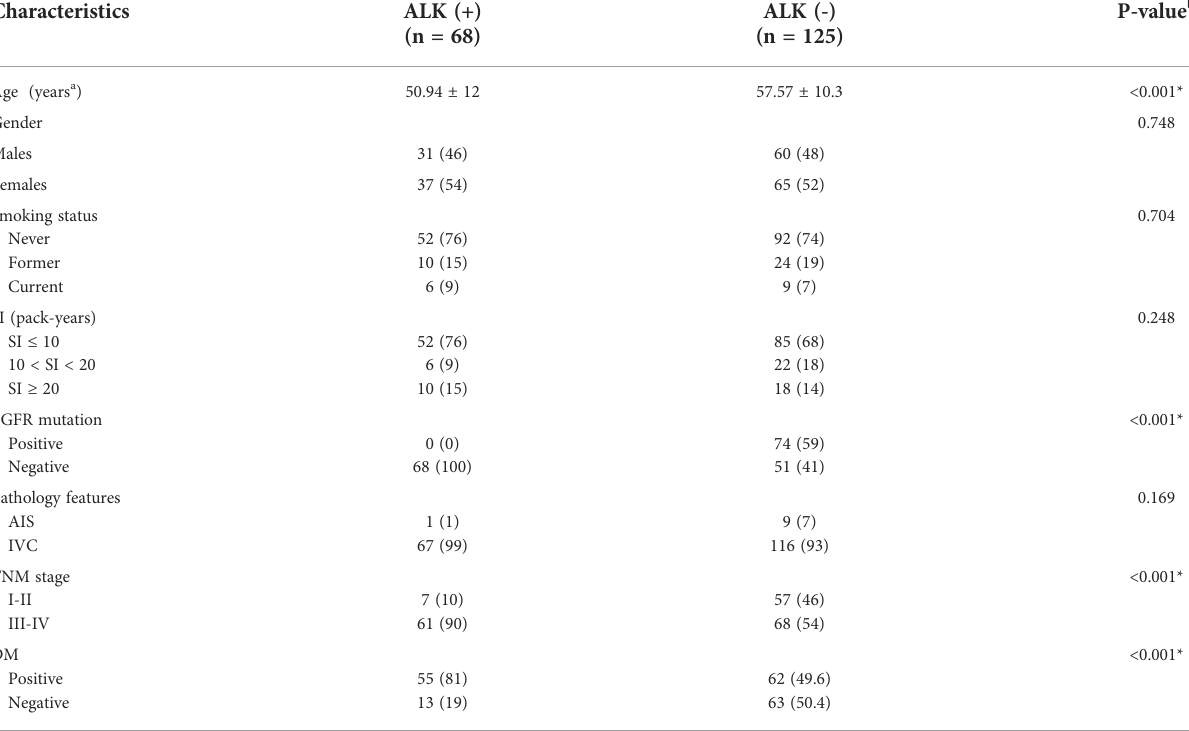
TABLE 1 Clinical characteristics of the ALK (+) and ALK (-)